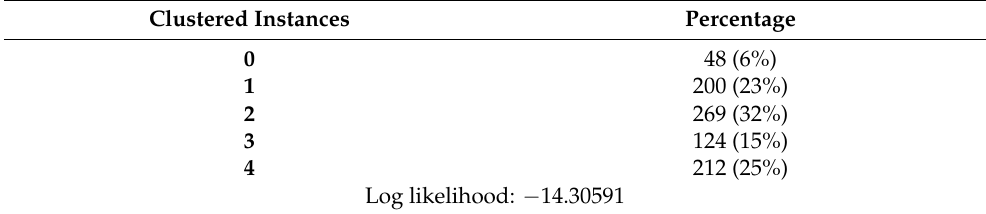
Figure 13. ( a ). Clustering based on availability through self-organizing map. ( b ). Clustering based on security through self-organizing map. ( c ). clustering based on reliability through self-organizing map. ( d ). Clustering based on cost through self-organizing map. ( e ). Clustering based on ranking through self-organizing map. Table 7. Clustering Based on Characterization. Table 8. Clusters’ Density Characterization.